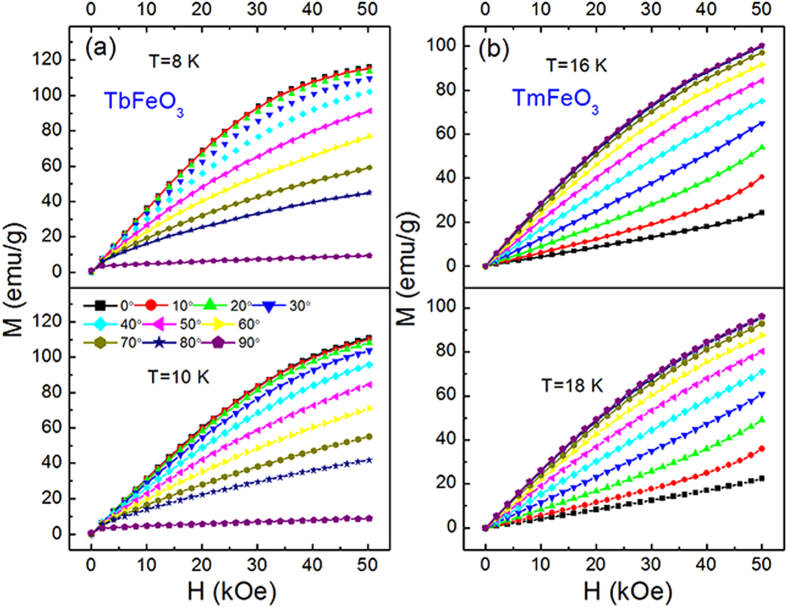
Representative isothermal magnetization curves at different angles in bc plane.(a) of TbFeO3 single crystal at 8 K and 10 K; (b) of TmFeO3 single crystal at 16 K and 18 K. 0 and 90 correspond to the b and c directions, respectively.